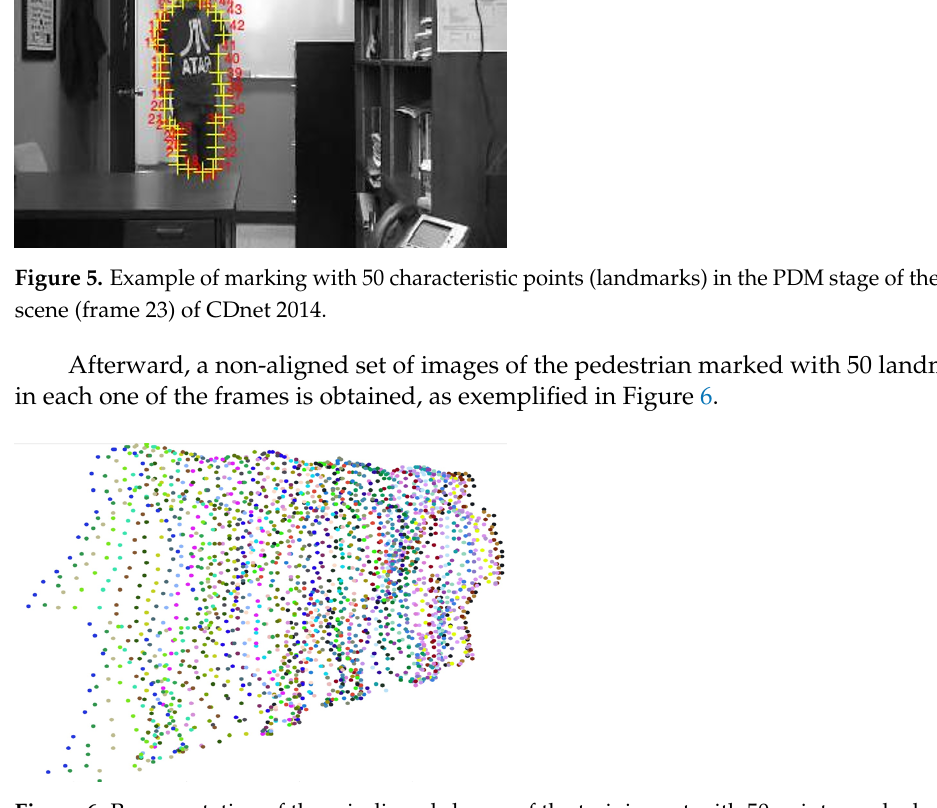
Figure 6. Representation of the misaligned shapes of the training set with 50 points marked.